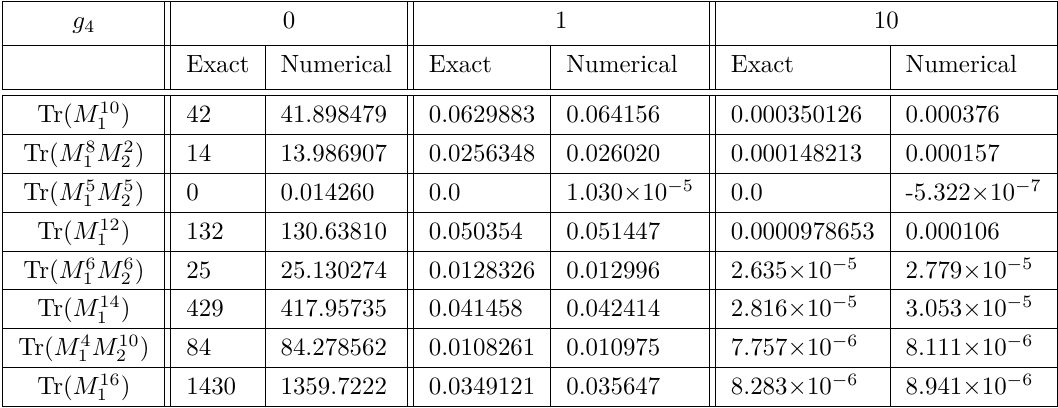
Table 3. Results for the g 3 = k = 0 as g 4 is varied. The loops shown have lengths ≥ 10 and ≤ 16